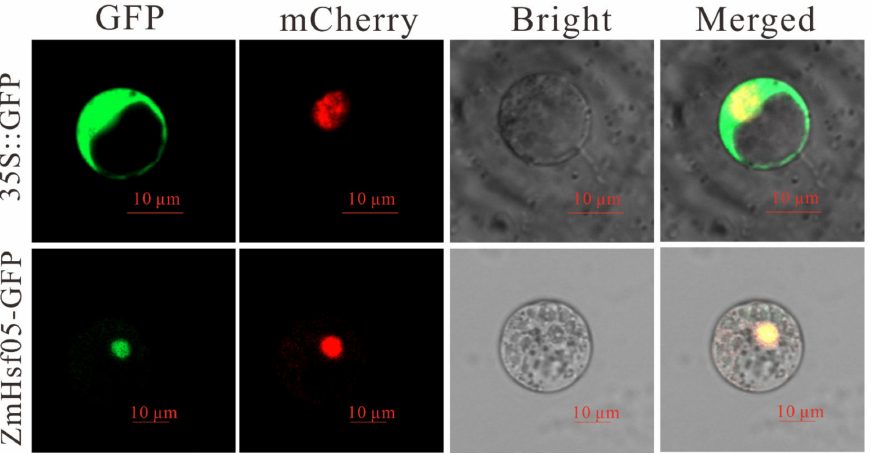
Figure 3. Subcellular localization of the ZmHsf05 protein. Subcellular localization of the ZmHsf05 protein in maize protoplast cells. The recombinant fluorescent proteins ZmHsf05 and GFP are local- ized in the nucleus, overlapped with the red fluorescent protein expressed from nuclear localization signaling protein (NLS). The 35S:GFP is used as a blank control, and ZmHsf05-GFP is the subcellular localization fusion vector of ZmHsf05. The green is the GFP protein signal, and the red fluorescence represents the nuclear localization signaling protein (NLS). (35S, CaMV 35S promoter; GFP, green fluorescent